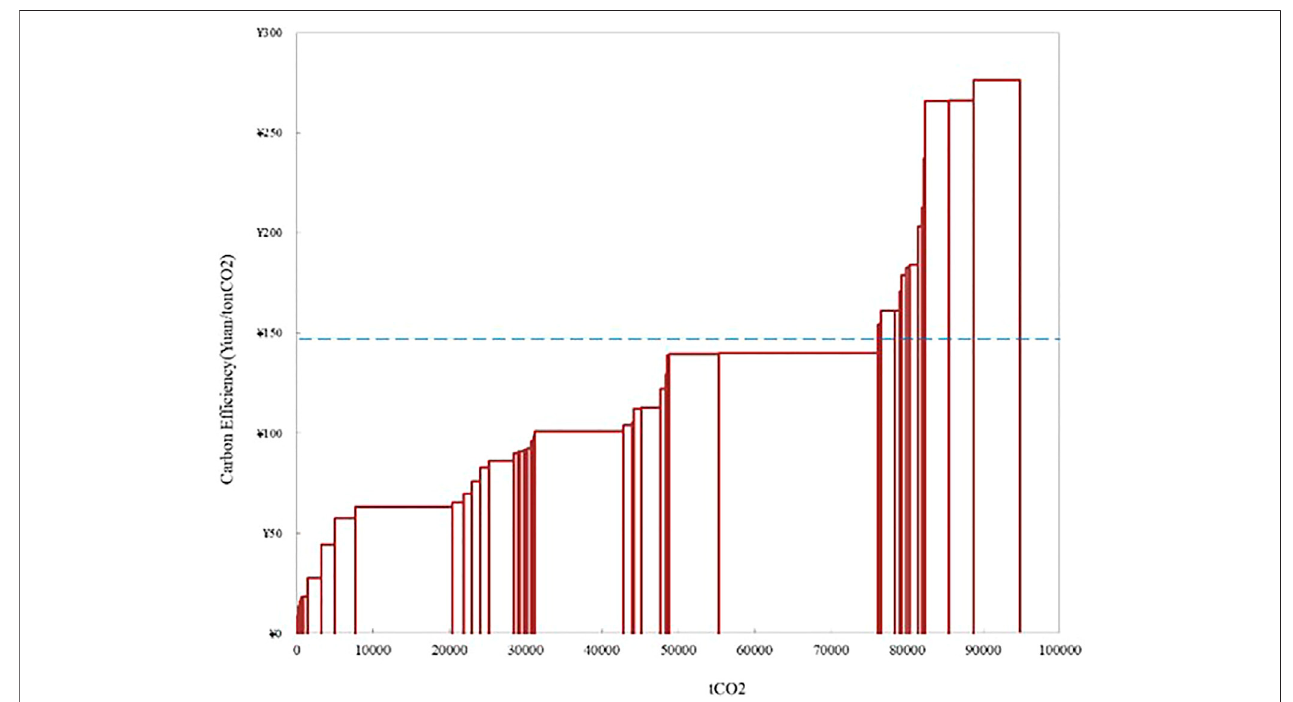
FIGURE 3 | Relationship between emission reduction potential and CEI. Data source: Local Statistical Yearbook and Bureau of Statistics.